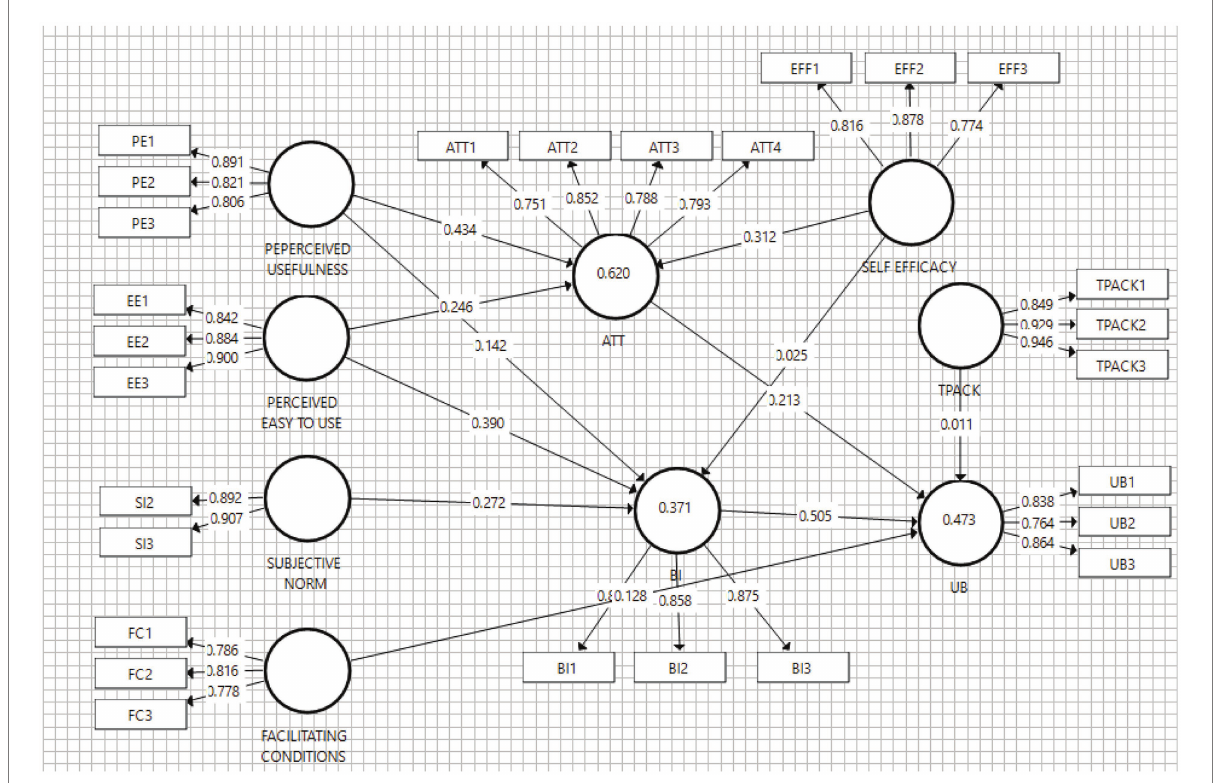
FIGURE 3 The structural model with factor loading and squared multiple correlations.